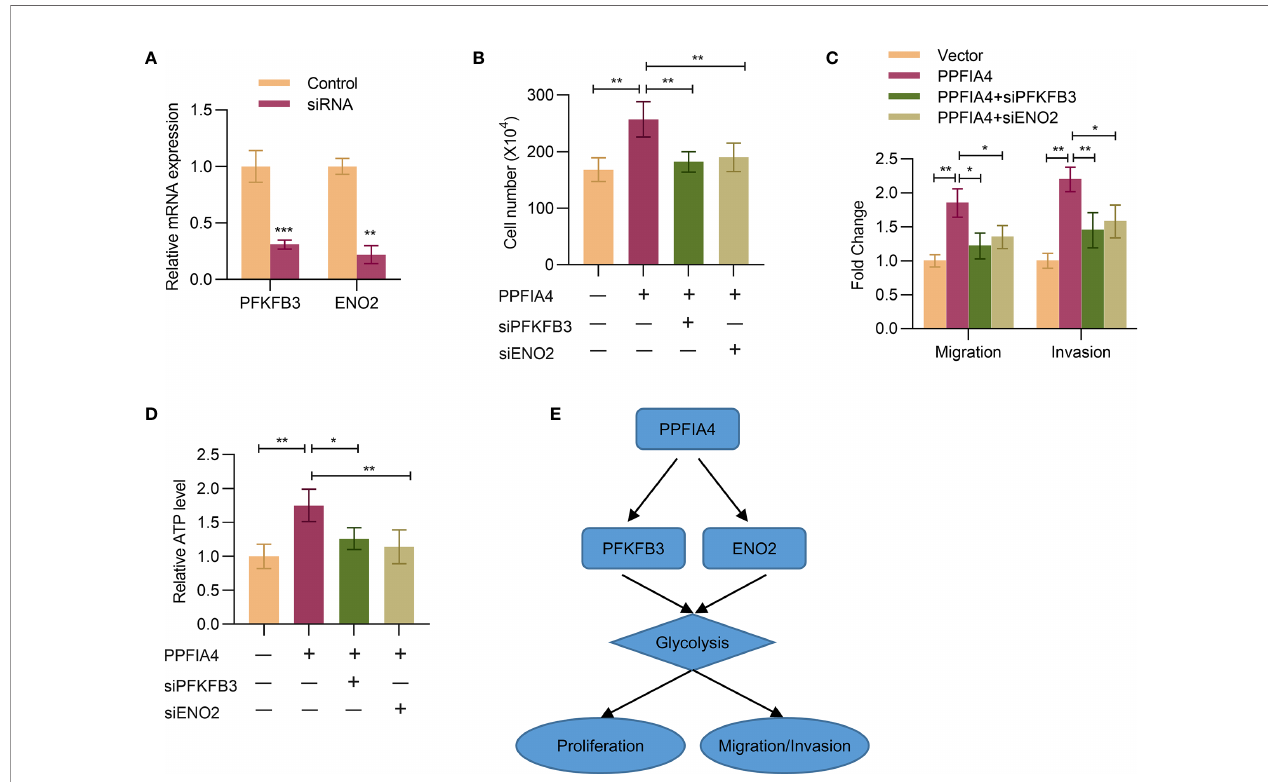
FIGURE 6 | PPFIA4 regulates PFKFB3 and ENO2 to promote colon cancer progression and glycolysis. (A) The mRNA expression of PFKFB3 and ENO2 in SW403 cells transfected with PFKFB3 or ENO2 siRNA was determined by qPCR. (B) Cell viability of SW403 cells transfected with PPFIA4 expression plasmid and with or without PFKFB3/ENO2 siRNA was determined by cell count assay. (C) Transwell analysis of the migration and invasion of SW403 cells transfected with PPFIA4 expression plasmid and with or without PFKFB3/ENO2 siRNA (D) Total ATP levels were measured in SW403 cells transfected with PPFIA4 expression plasmid and with or without PFKFB3/ENO2 siRNA. (E) A diagram for the possible mechanisms. *p < 0.05, **p < 0.01, ***p <